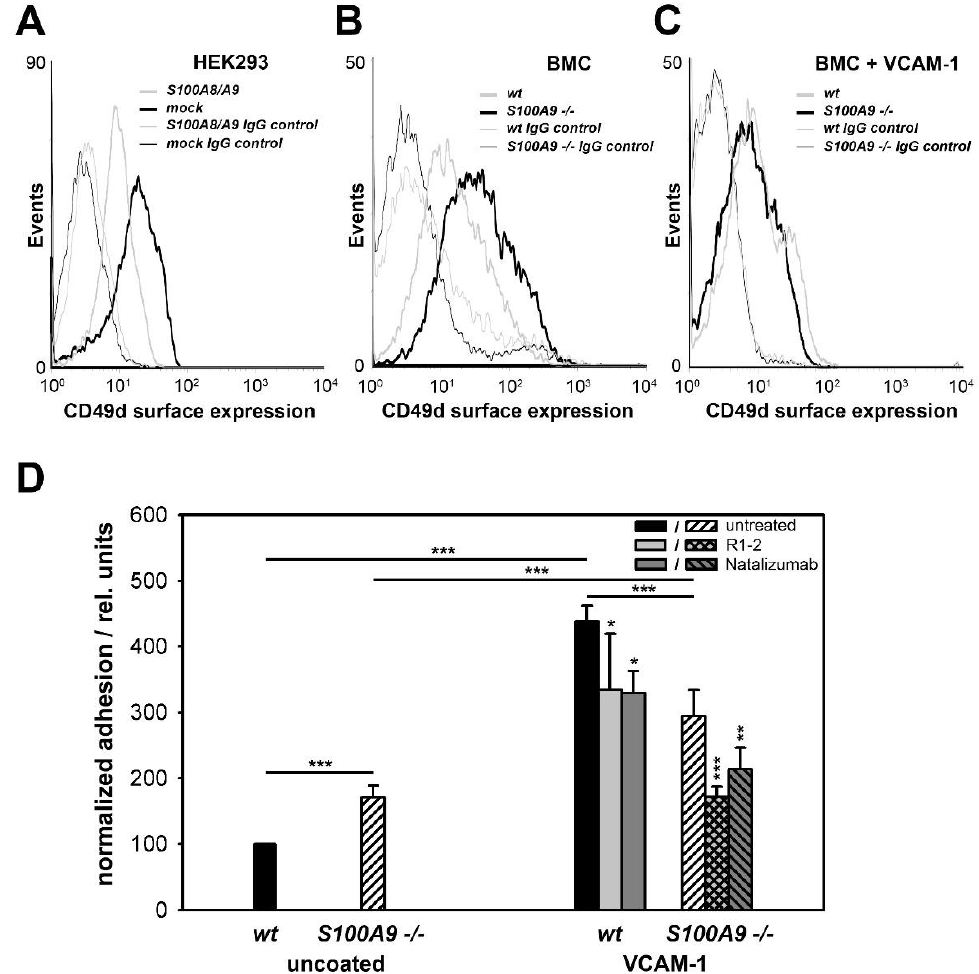
Figure 6. CD49d surface expression was differentially regulated in the S100A8/S100A9-expressing cells, causing a change in substrate adhesion. ( A – C ) CD49d surface expression of S100A8/S100A9- expressing HEK293 cells or the murine wildtype (wt) BMCs in the absence ( A , B ) or presence ( C ) of the CD49d ligand VCAM-1 compared to the mock transfected HEK293 or S100A9 -/- cells and isotypic controls analyzed by flow cytometry. ( D ) Adhesion assay of murine wildtype and S100A9 -/- BMCs in the absence or presence of VCAM-1 (coating conditions: 1 µg/mL, 16 h, 37 °C). Cells were allowed to adhere for 1 h. In the absence of VCAM-1, S100A9-deficient BMCs showed higher adhesion properties compared to the wildtype cells. However, the wildtype BMCs showed a stronger increase in adhesion in the presence of VCAM-1, which significantly surpassed that of S100A9-deficient cells. Adhesion of both wt as well as S100A9 -/- cells was lowered via CD49d blocking. BMCs from the wildtype and S100A9 -/- mice were preincubated for 30 min with 10 µg/mL of the CD49d blocking antibodies R1-2 or with 10 µg/mL natalizumab, followed by the adhesion assays as described above. All data were normalized to untreated wildtype cells in the absence of VCAM-1 set to 100; n = 4; mean ± SD; *** p < 0.001; ** p < 0.01; * p < 0.05; significance levels (asterisks) refer to the comparison to corresponding untreated cells if not otherwise indicated.